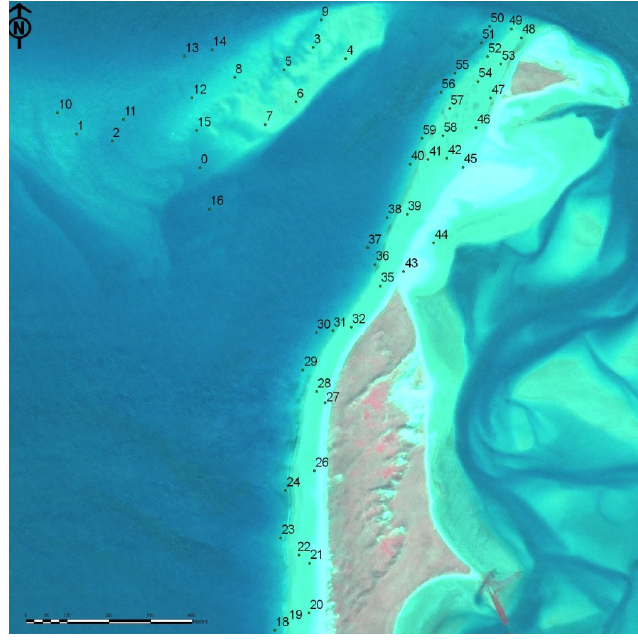
Figure 2. Sediment sample locations.